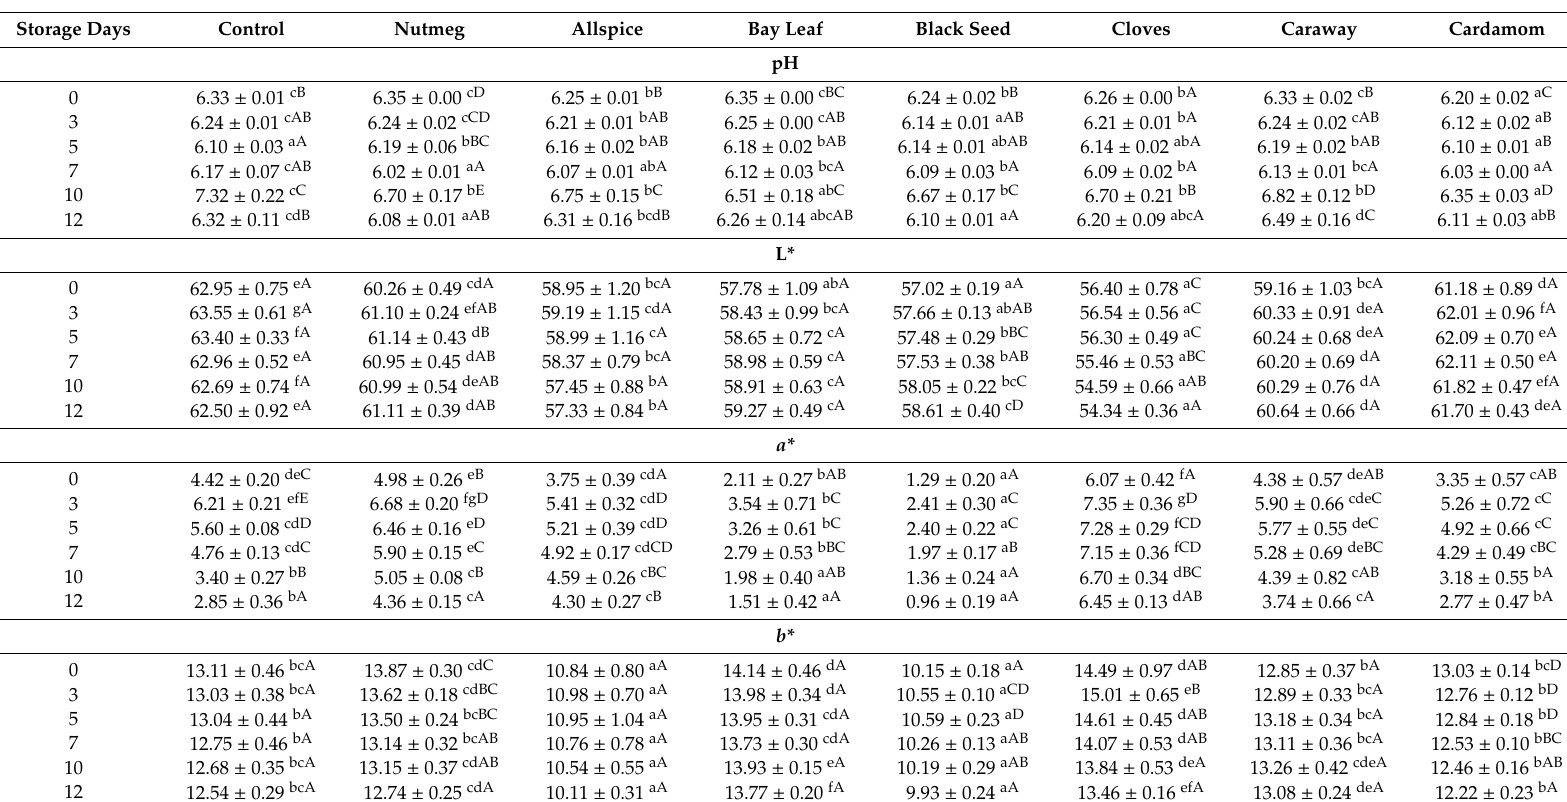
Table 4. E ff ect of various spice extract treatments on pH values and color coordinates (L*a*b*) of raw ground chicken legs during 12 days of refrigerated storage (4 ◦ C). Storage